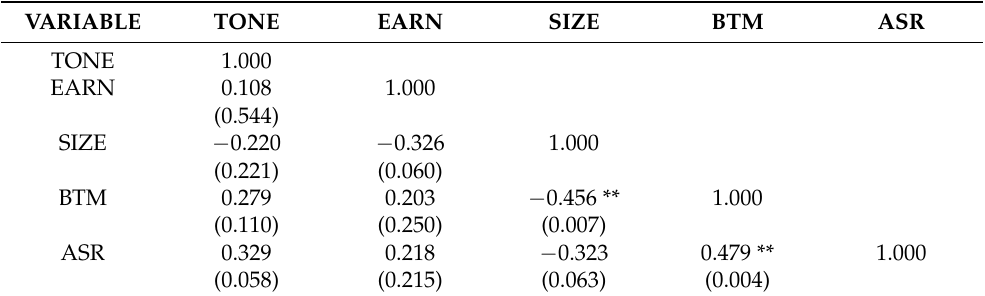
Table 4. Correlation